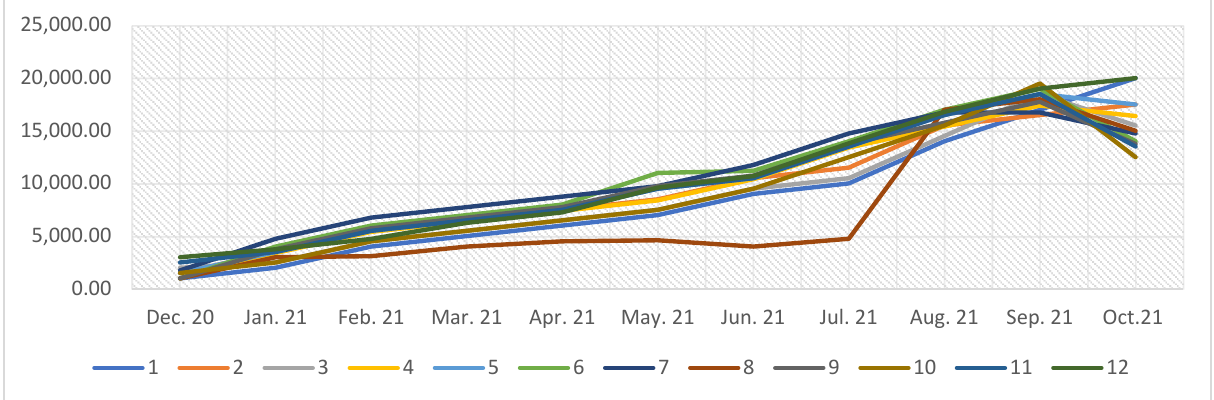
Figure 6. The frequency of each topic on Twitter weekly. Notes: The number from 1 to 12 represent the topics.